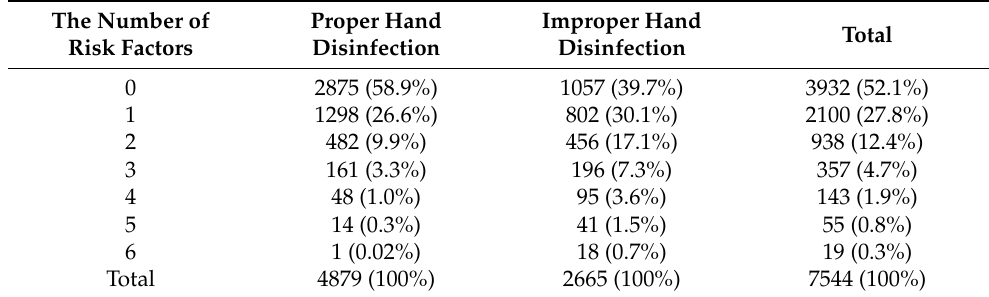
Table 7. Assessment of the correctness of hand disinfection, depending on the number of risk factors (deviations in hand preparation).